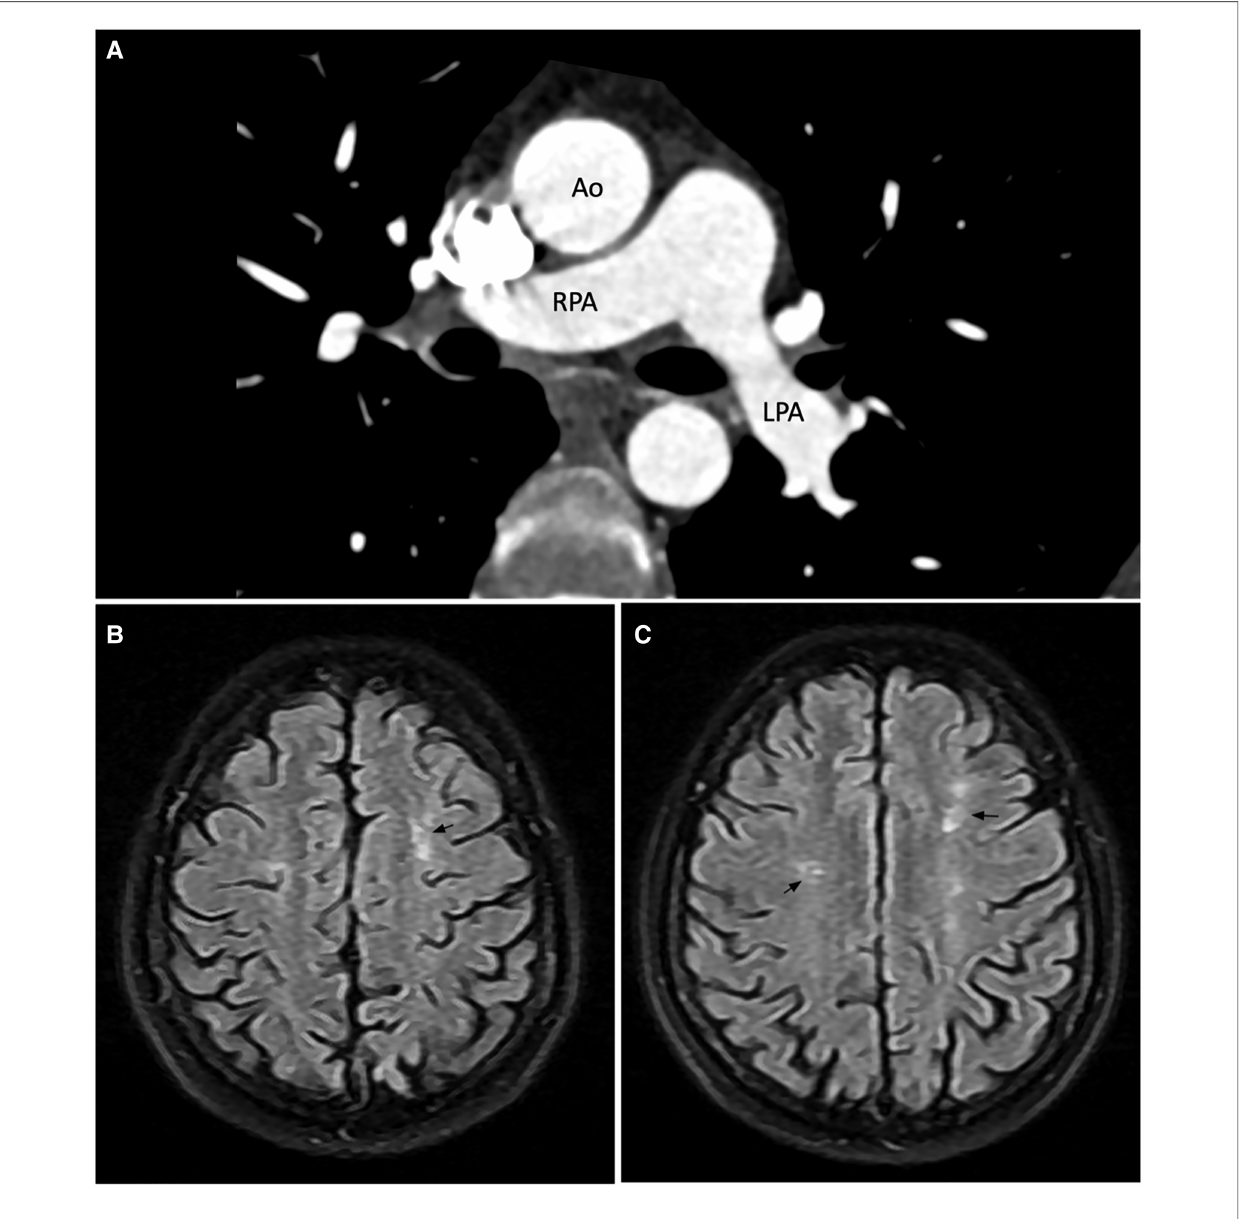
FIGURE 3 Computed tomography pulmonary angiogram ( A ) and brain magnetic resonance imaging scan ( B,C ). ( A ) No large pulmonary emboli on CTPA. (B,C) Axial FLAIR image showed bilateral hyperintense white matter lesions in the frontal lobes. The number of lesions is more than expected for the patient ’ s age. Annotations: Ao, aorta; RPA, right pulmonary artery; LPA, left pulmonary